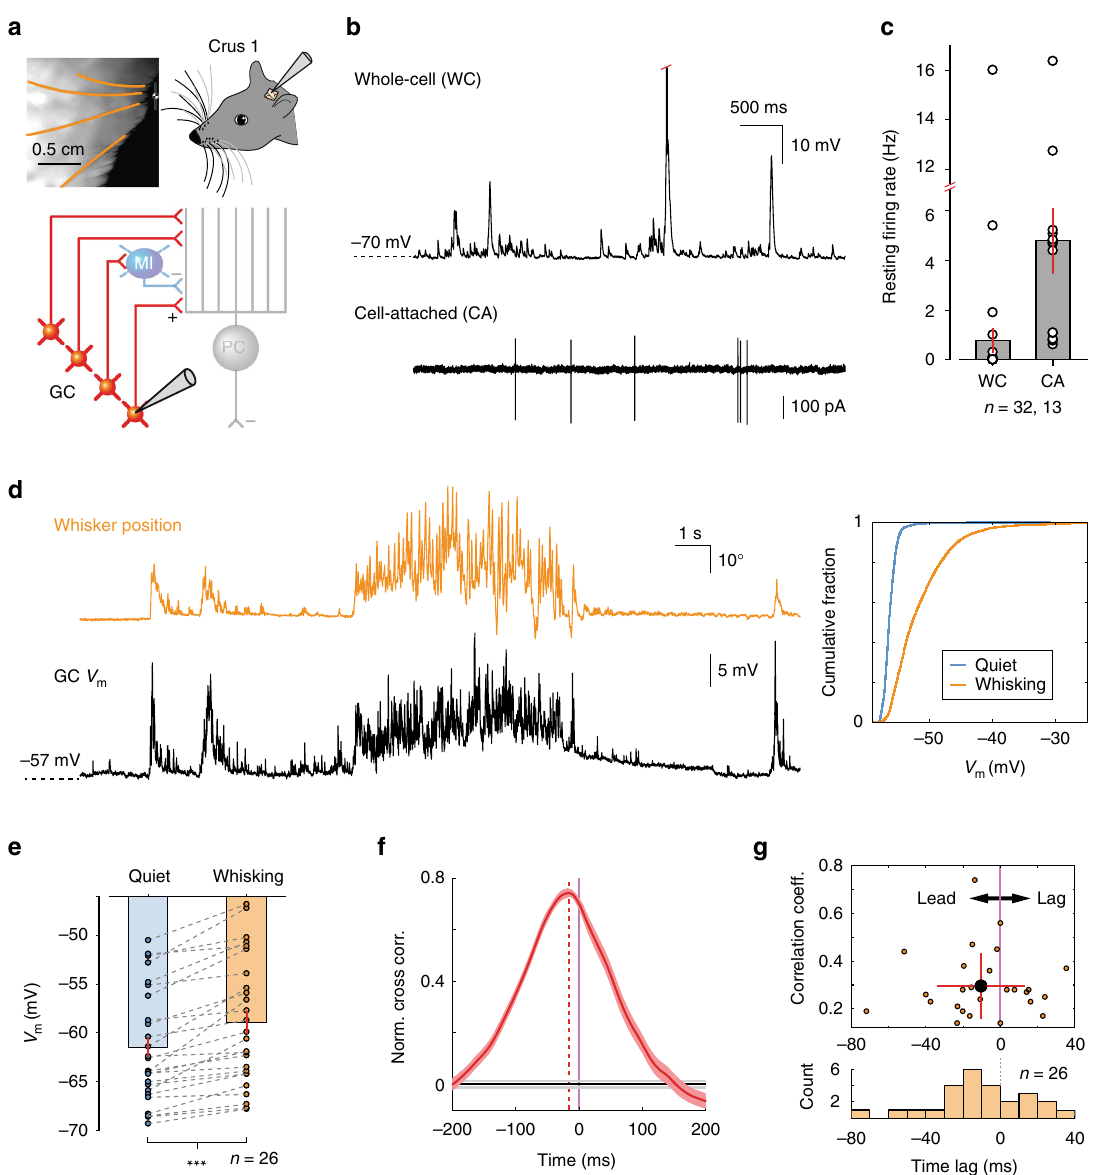
Fig. 1 Whisking drives membrane potential depolarisation in cerebellar granule cells of awake mice. a Top left : videography of a head-restrained mouse with four traced whiskers (from row C, labelled in orange ). Top right : schematic of experimental setup. Patch clamp recordings were made from lobule Crus 1 of the cerebellar cortex. Bottom : schematic representation of cerebellar circuit highlighting granule cells in the input layer. GC granule cell, MI molecular layer interneuron, PC Purkinje cell. b Top : whole-cell ( WC ) patch clamp recording from GC. Red tick indicates truncated action potential. Bottom : cell-attached ( CA ) recording from putative GC. c Resting GC fi ring rates in the absence of movement ( n = 32 WC, n = 13 CA). A total of 26 out of 32 GCs were silent in WC con fi guration. d Left : example traces of whisker position ( orange ; upward de fl ection indicating protraction) and simultaneously recorded GC membrane potential V m ( black ). Right : cumulative probability of V m distribution during quiet and whisking epochs for this GC ( P < 0.001, Kolmogorov – Smirnov test). e Mean V m in periods of quiet and whisking for all GCs that showed statistically signi fi cant differences in V m distribution between two conditions. V m is signi fi cantly depolarised during whisking (*** P < 0.001, Wilcoxon signed-rank test, n = 26). f Normalised cross-correlation between whisker position and V m for a single GC. Purple line at zero depicts whisking onset. Vertical red dashed line highlights the peak in the cross correlogram, indicating temporal relationship between behaviour and GC V m . Horizontal grey lines : 95% con fi dence interval. GC exhibited depolarisation preceding the onset of whisking. g Top : scatter plot, indicating temporal relationship and strength of correlation between whisker position and GC V m . Black- fi lled circle : Mean ± S.D. Bottom : histogram of temporal relationship between behaviour and GC V m ( n =